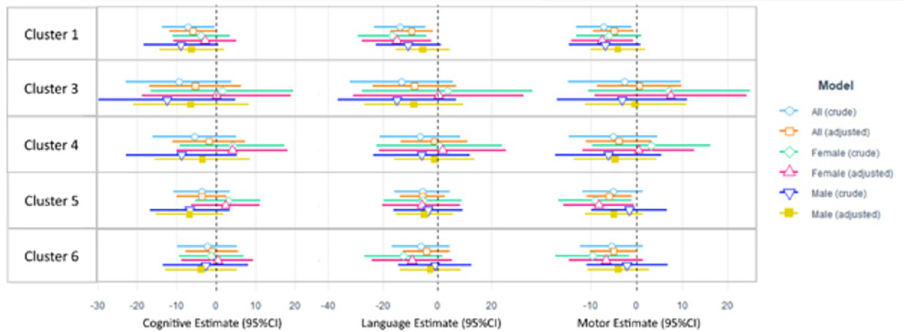
Fig 3. Assessment scores from linear regression models. Crude and adjusted linear regression models for the three outcomes of interest and the clusters from the profile regression. Cognitive Score Model adjusted for genetic anomaly, gestational age, and raw Hollingshead SES score. Language Score Model adjusted for genetic anomaly, raw Hollingshead SES score, and sex. Motor Score Model adjusted for ethnicity, genetic anomaly, sex, and hospital length of stay at first operation. Cluster 2 is the lowest exposure cluster and is set as the reference group for each model.